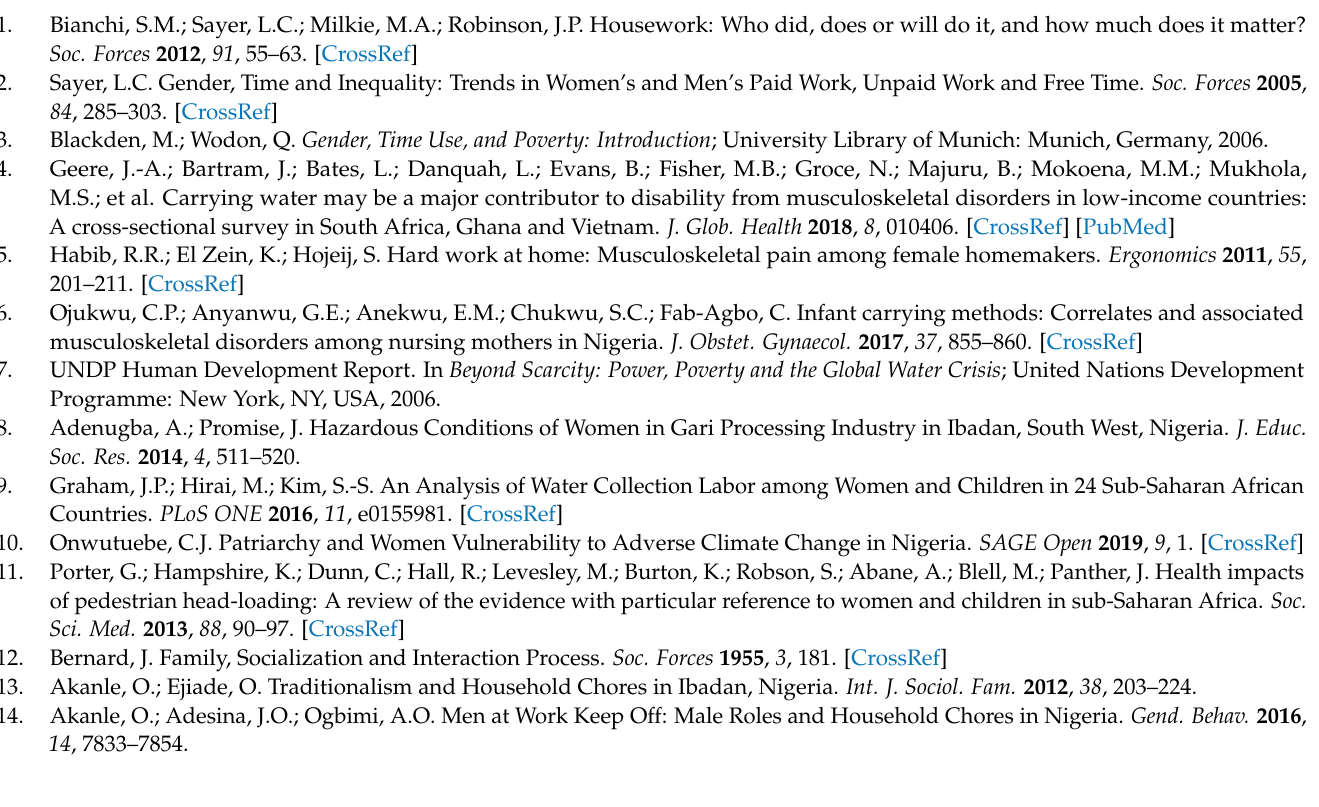
Table S2: The final domestic work experience survey questions. Table S3: Correlation between and across DWE regression-based factor scores. File S1: The Domestic Work Experience Questionnaire (Original